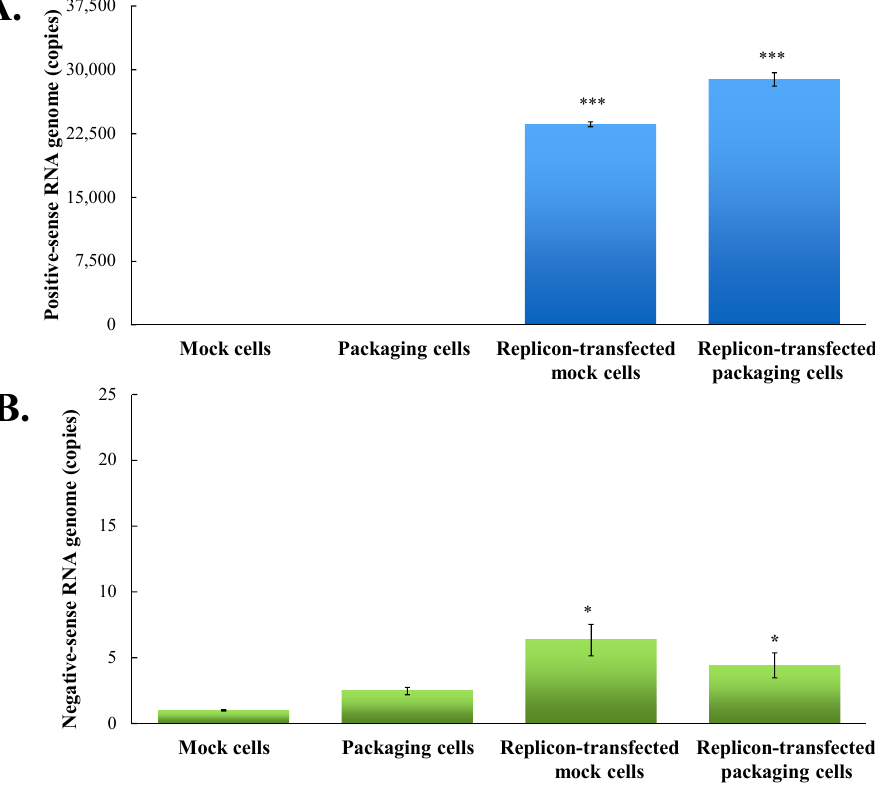
Figure 3. Quantitative analysis of positive ‐ and negative ‐ sense JEV subgenomes using strand ‐ specific real time RT ‐ PCR. Total RNAs were extracted from mock cells, packaging cells, replicon ‐ transfected mock cells and replicon ‐ transfected packaging cells; relative copy numbers of positive ‐ ( A ) and negative ‐ sense ( B ) subgenomes were quantitated using real ‐ time PCR, and then normalized by GAPDH mRNA. *, p ‐ value < 0.05; ***, p ‐ value < 0.001 compared with mock cells.